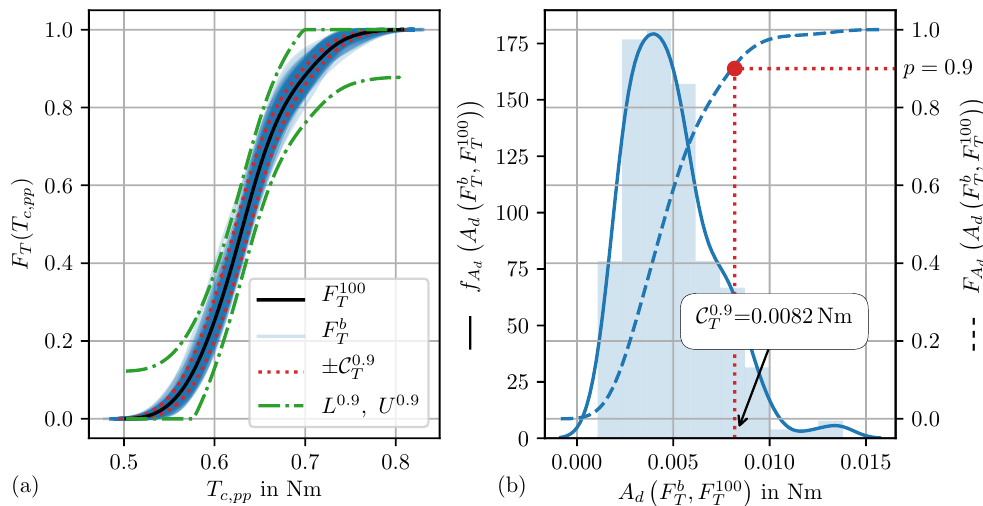
Figure 7. Derivation of the confidence value: ( a ) CDF of the original set of samples F 100 from batches, F b ; interpretation of the 90% confidence value T confidence band based on Equations (3)–(5), L 0.9 , U 0.9 and ( b ) probability density function f A CDF F A of the deviations of batch CDFs to original data d